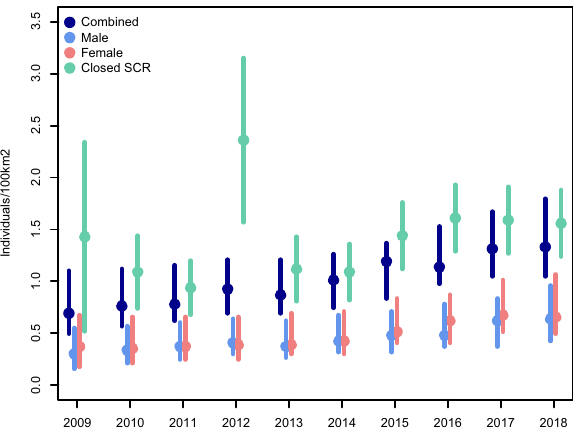
Figure 2. Posterior modes and 95% highest posterior density (HPD) intervals of open population spatial capture–recapture (SCR) models referring to combined, male and female lynx densities.